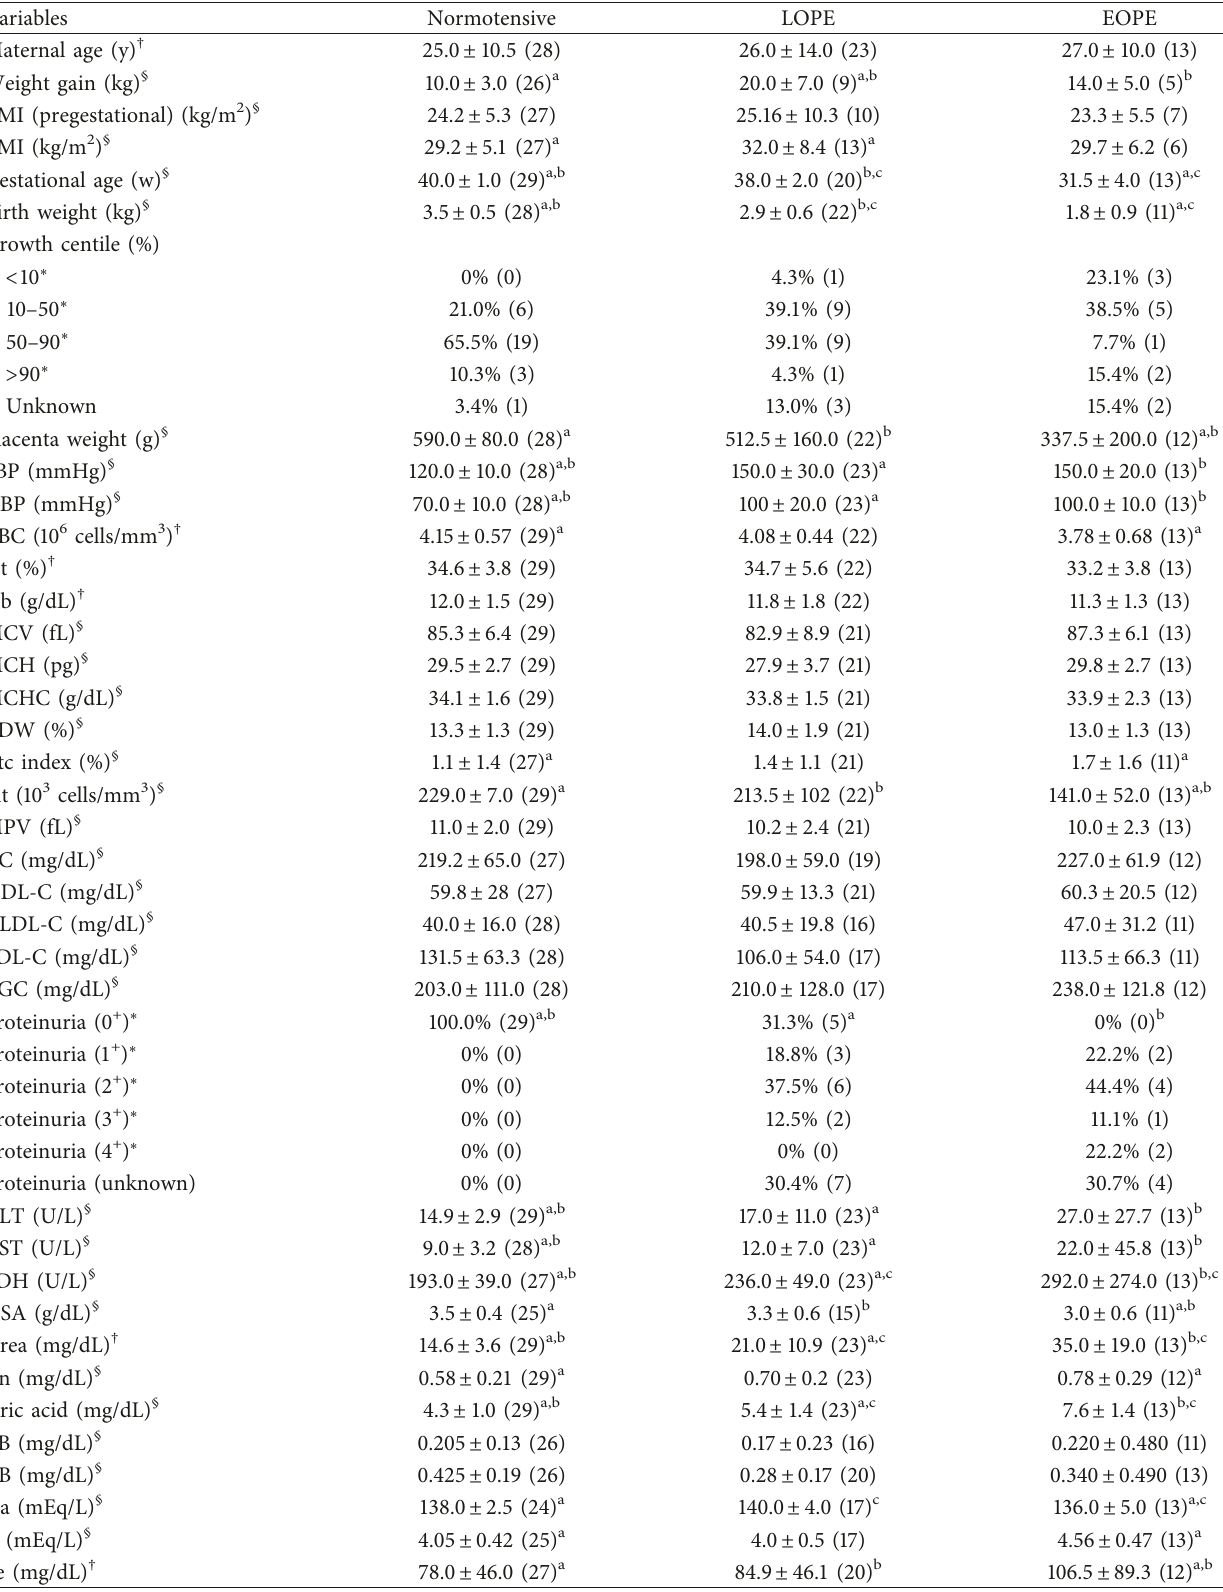
Table 1: Comparisons of the values of variables from normotensive pregnant women and pregnant women with late-onset preeclampsia (LOPE) and early-onset preeclampsia (EOPE) at the third trimester of